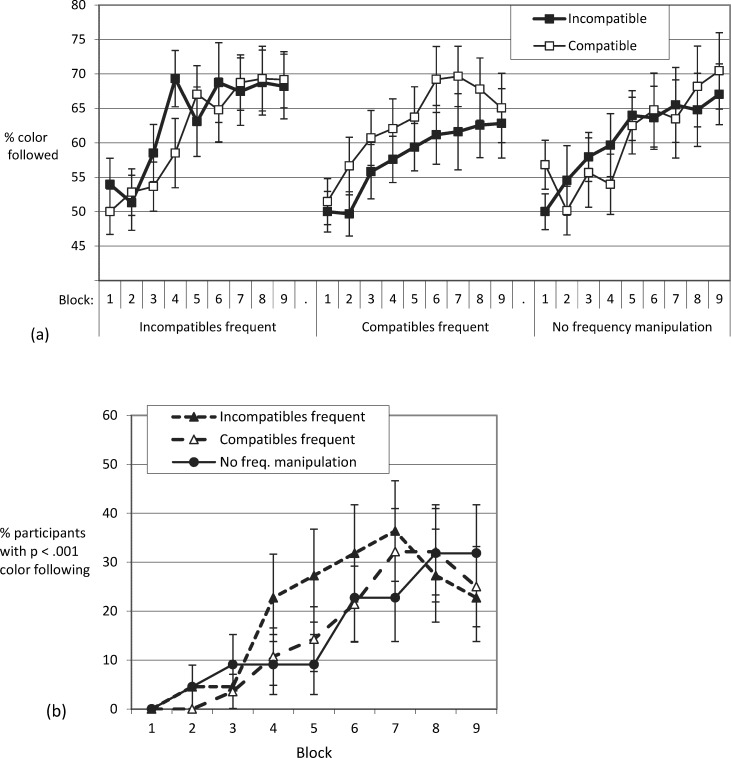
Exp. 2: Color usage in ambiguous trials.Panel (a) shows the average color usage in ambiguous trials increasing across blocks of practice for frequent and infrequent color-position pairings and for participants who experience spatially incompatible stimulus-response mappings frequently vs. infrequently. Panel (b) shows the practice-related increase in the proportion of participants who strongly use color. Error bars depict the between-subjects standard error of the mean.